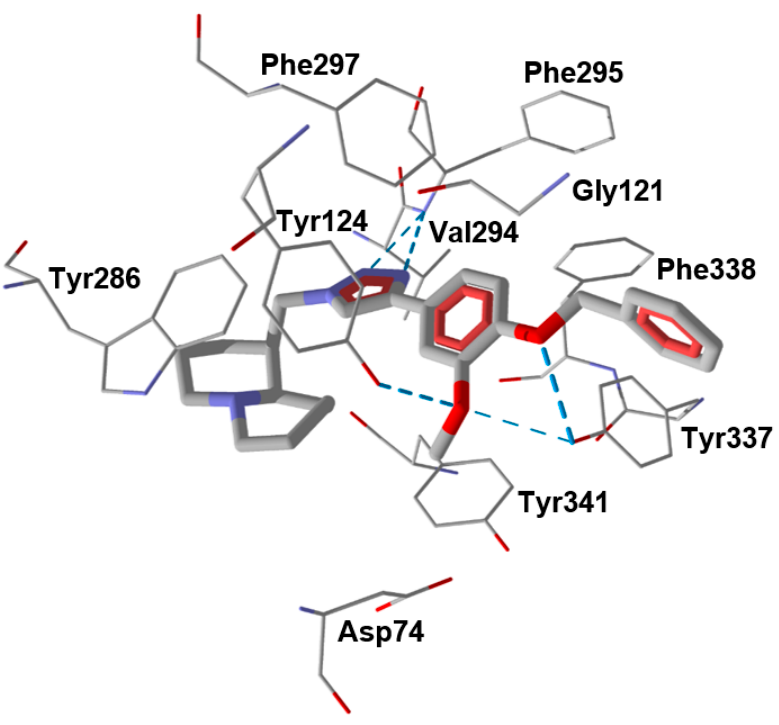
Figure 2. Docking poses of compound 15 in AChE (PDB code 4EY7). H-bonds are shown in blue dashed lines. Residues within 2.5 Å of each pose are visible. For comparative purposes, we modeled three other previously reported AchE inhib- itors ( A – C ) with molecular topology analogous to compound 15 [36–38] (Table 3). The docking computations for these ligands led to docking poses positioned within the AChE binding site similarly to 15 (Figure 3), and with interface energies indicating strong bind-